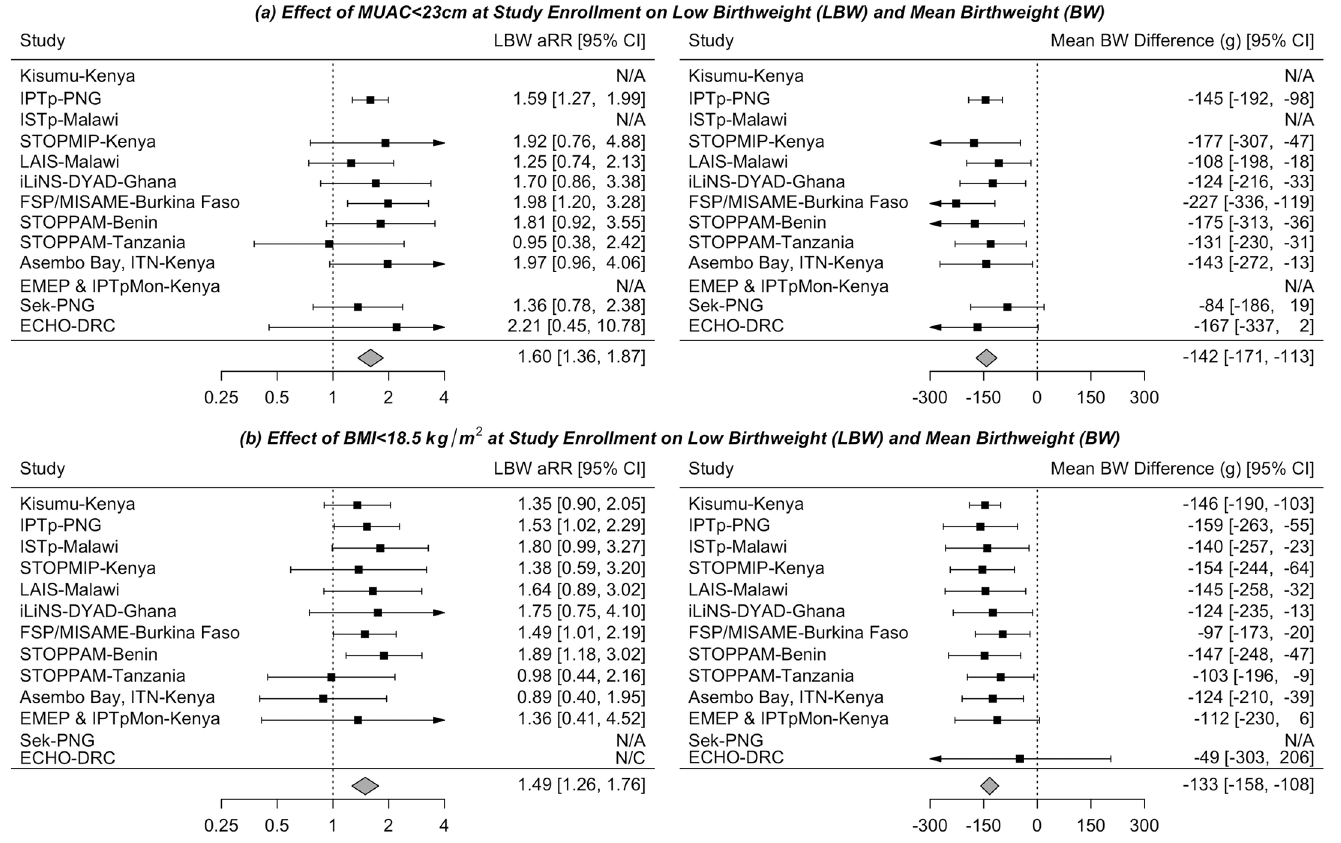
Fig 4. The independent effect of malnutrition at enrollment, (a) mid-upper arm circumference (MUAC) < 23 cm and (b) Body Mass Index (BMI) * < 18.5 kg/m 2 , on risk of low birthweight (LBW) and mean birthweight among 14,633 women enrolled in 1 of 13 studies from the Maternal Malaria and Malnutrition (M3) initiative from 1996 to 2015. BMI is adjusted for gestational age to reflect the estimated first trimester weight. Inverse probability of treatment weighted(IPTW) estimates controllingfor confounding betweenmalnutrition (MUAC or BMI) at enrollment and LBW by maternal age, gravidity, area of residence, anemia,and HIV infection(where available). BMI, Body mass index; BW, Birthweight. CI, Confidenceinterval; DRC, Democratic Republicof the Congo; MUAC, mid-upper arm circumference; N/A, not available; N/C, no model convergence; PNG, Papua New Guinea.